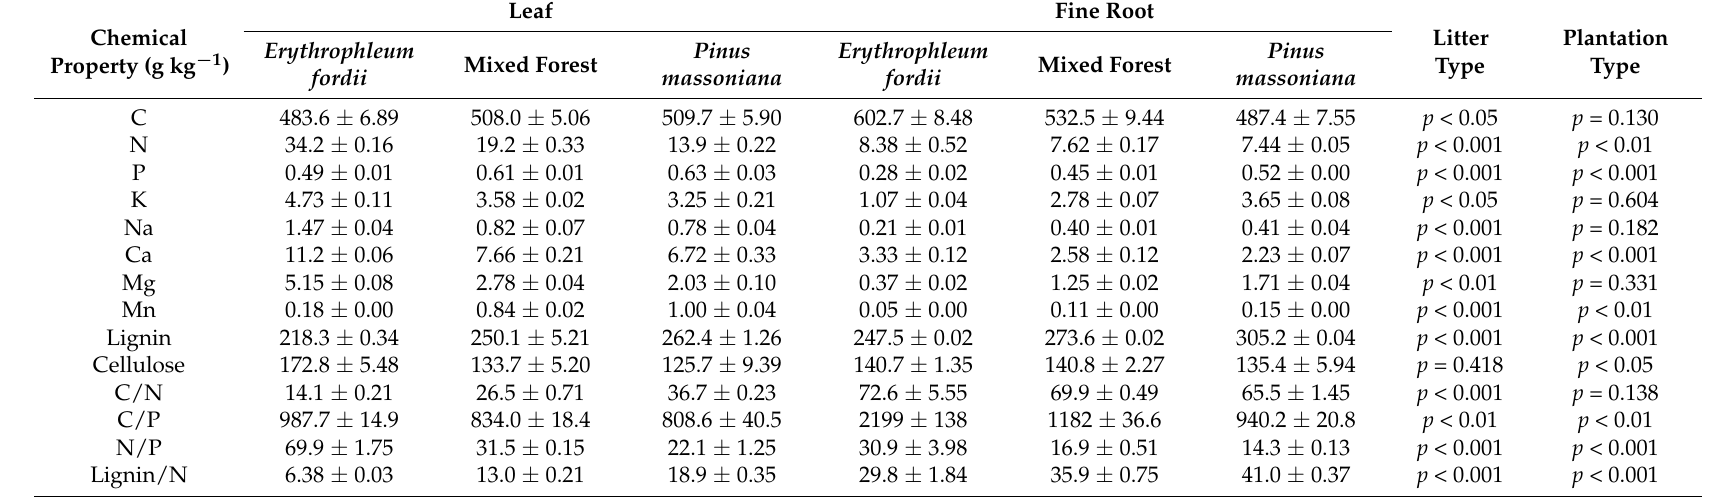
Table 1. Initial chemical properties of leaf and fine root litter of three subtropical plantations in China. Values are mean ± standard error ( n = 3).